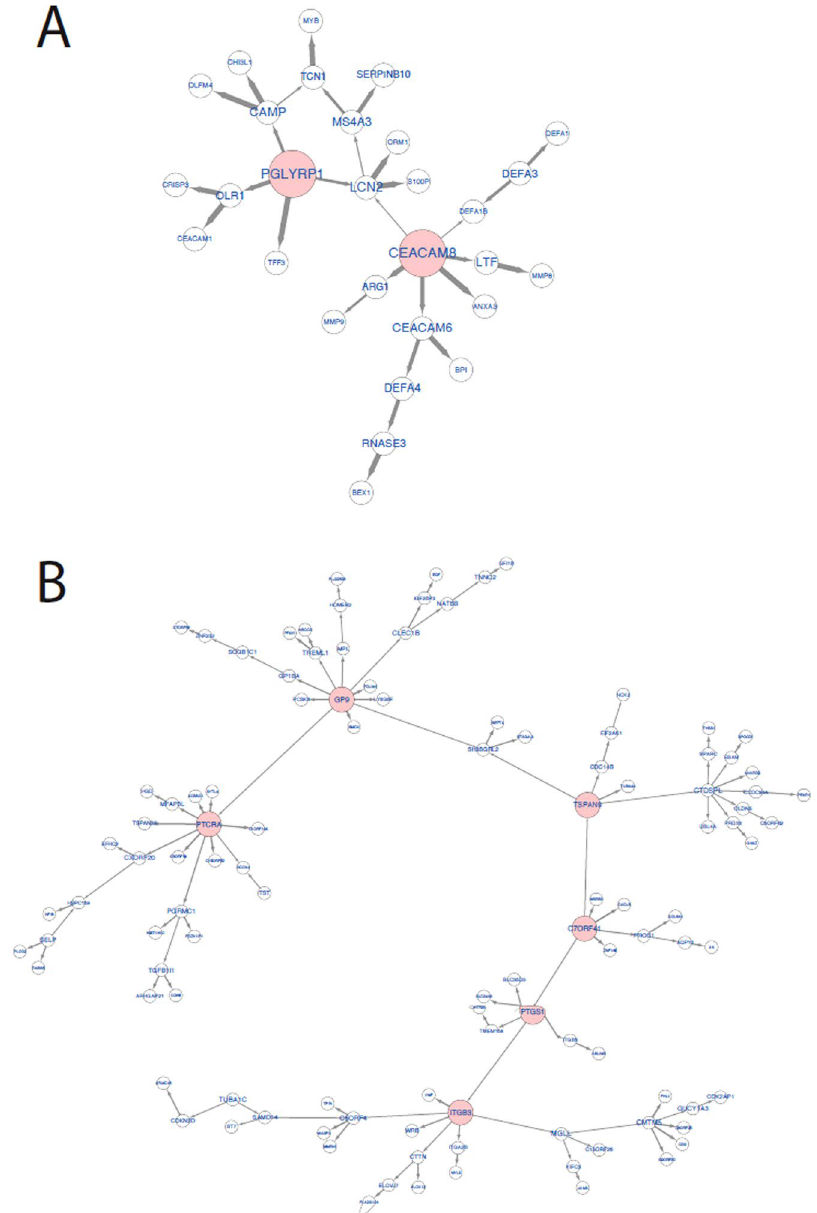
Figure 3. Bayesian network directed subgraphs around key driver